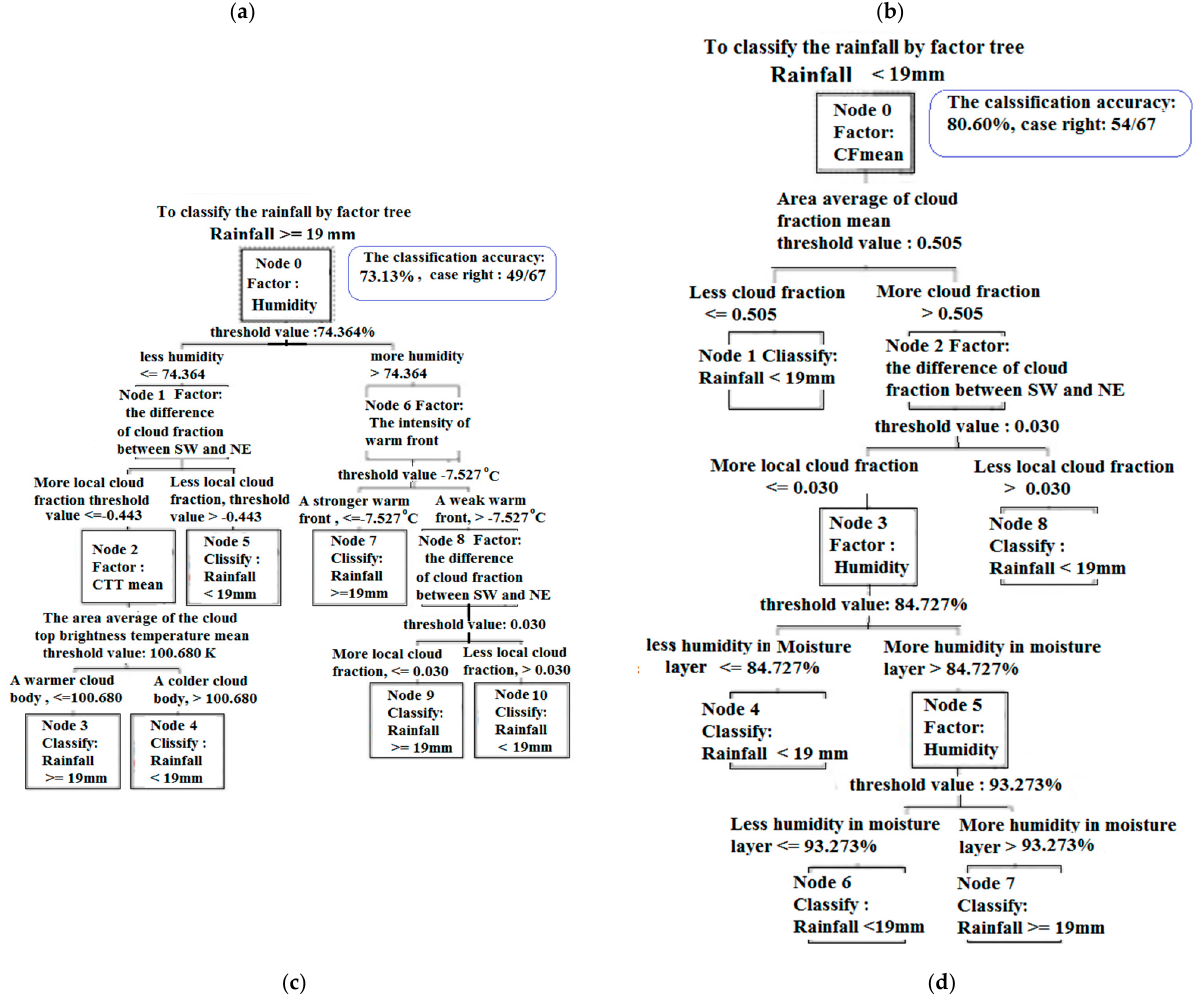
Figure 11. Four decision trees for judging four precipitation grade groups. ( a ) a decision tree for precipitation ≥ 30 mm, ( b ) a decision tree for precipitation < 30 mm, ( c ) a decision tree for precipitation ≥ 19 mm, ( d ) a decision tree for precipitation < 19 mm.